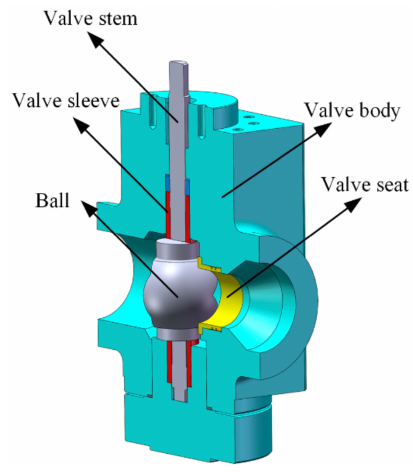
Figure 1. Structure of the V-ball